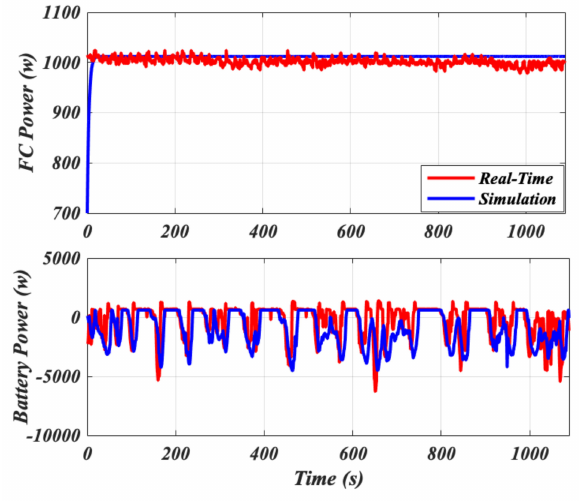
Figure 13. Real-time results of the PEMFC power and the battery power.